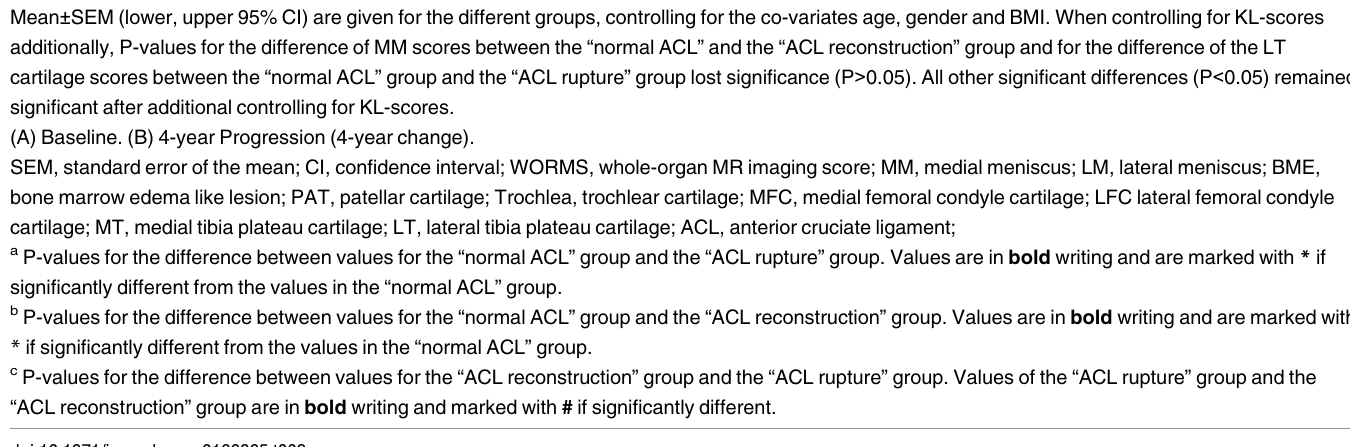
(rho = 0.38, P = 0.005), high lateral meniscus (LM) scores (rho = 0.33, P = 0.018) and high cartilage scores (rho = 0.35, P = 0.012), in particular at the LT (rho = 0.43, P = 0.002), LFC (rho = 0.38, P = 0.005) and trochlea (rho = 0.41, P = 0.003). Flexion and extension strength did not show any significant correlation with WORMS scores (P > 0.05). There was no significant correlation between muscle characteristics and WORMS progression over 4 years (data not shown).